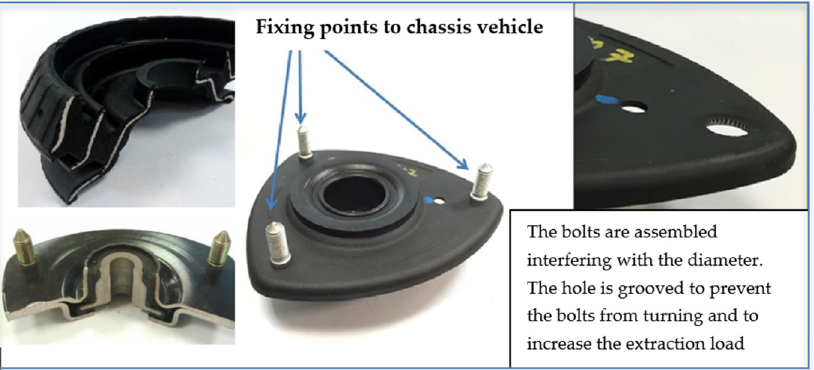
Figure 1. Anti-vibration and damping components with steel plates.